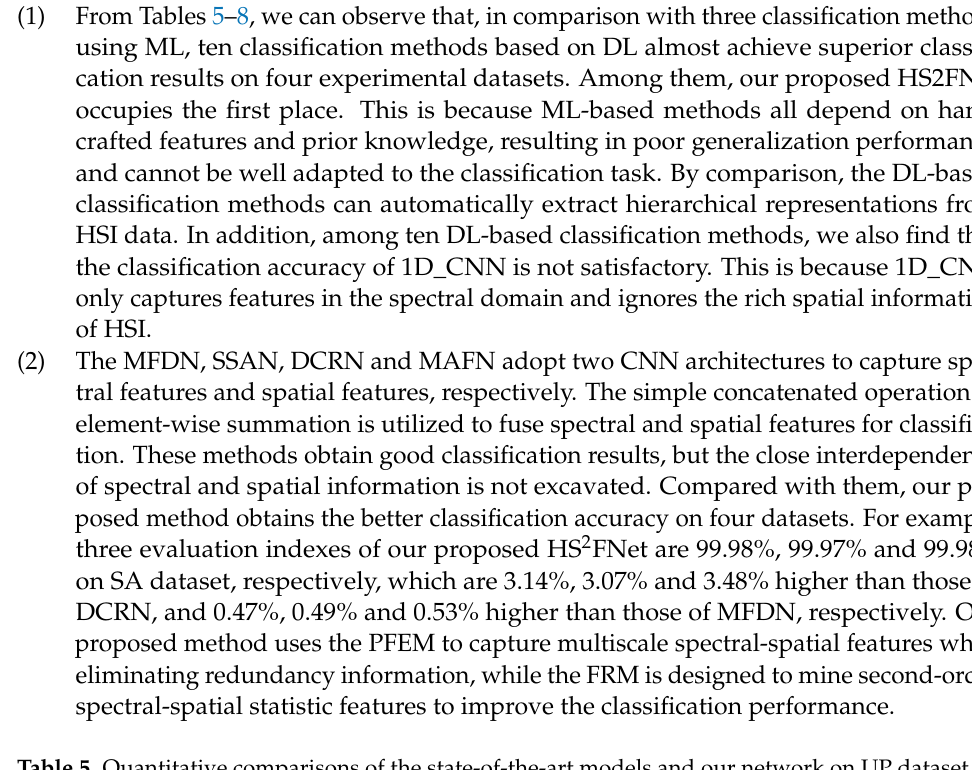
Table 5. Quantitative comparisons of the state-of-the-art models and our network on UP dataset.